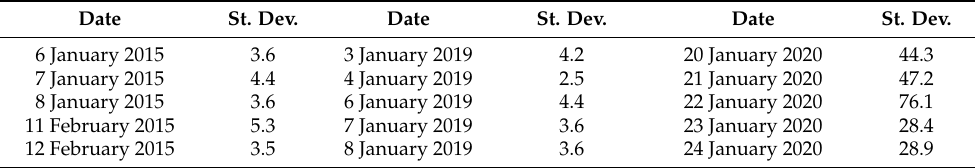
Table 4. Daily statistical parameters for the differential phase shift. Values are in